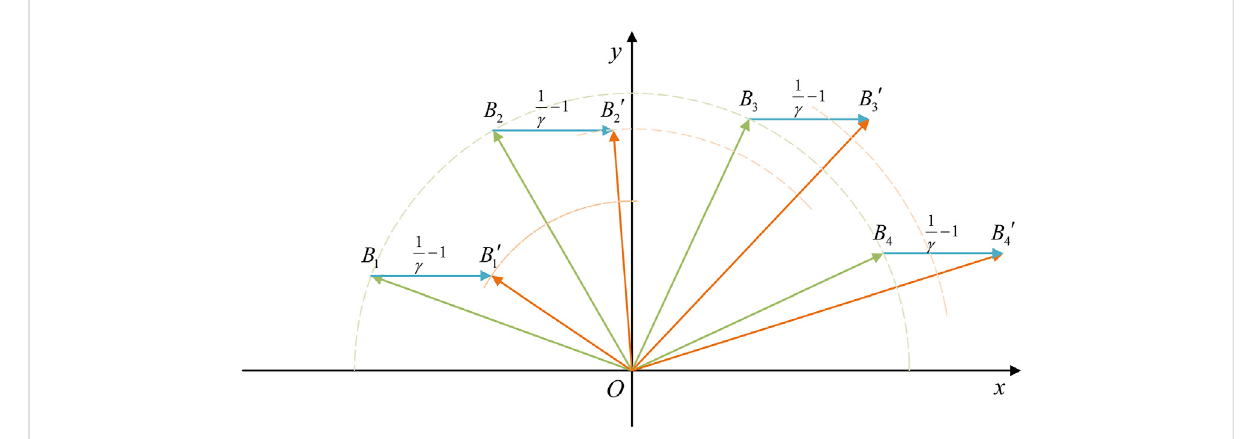
FIGURE 5 Decomposition of the phase factor when s is even.